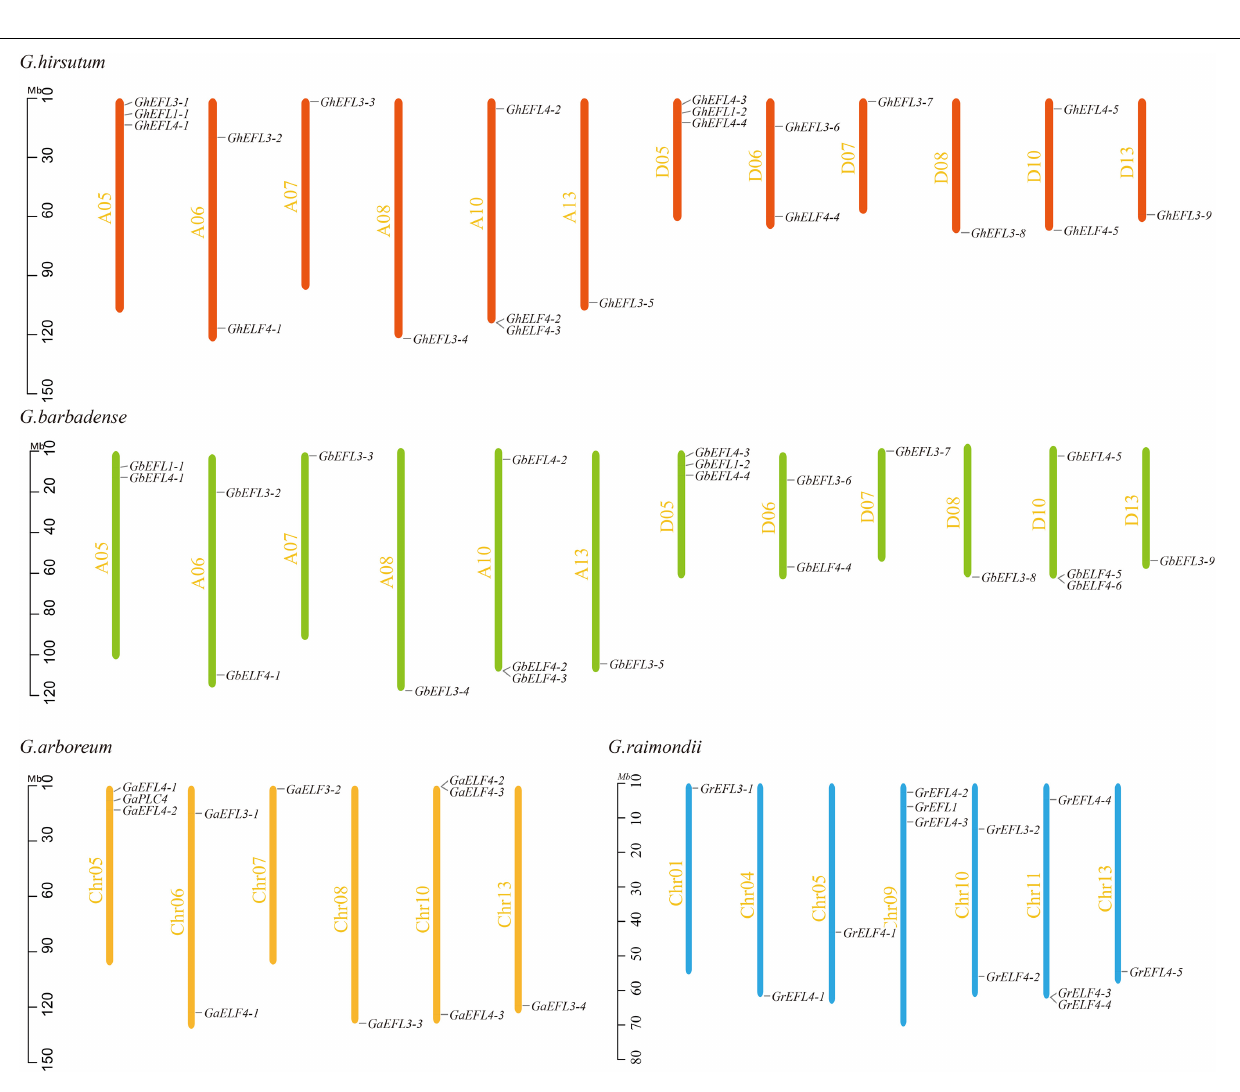
FIGURE 1 | Chromosomal distribution of ELF4s in Gossypium raimondii , G. barbadense , G. arboreum , and G. hirsutum . The scale represents megabases (Mb). The chromosome numbers are indicated on the left of each vertical